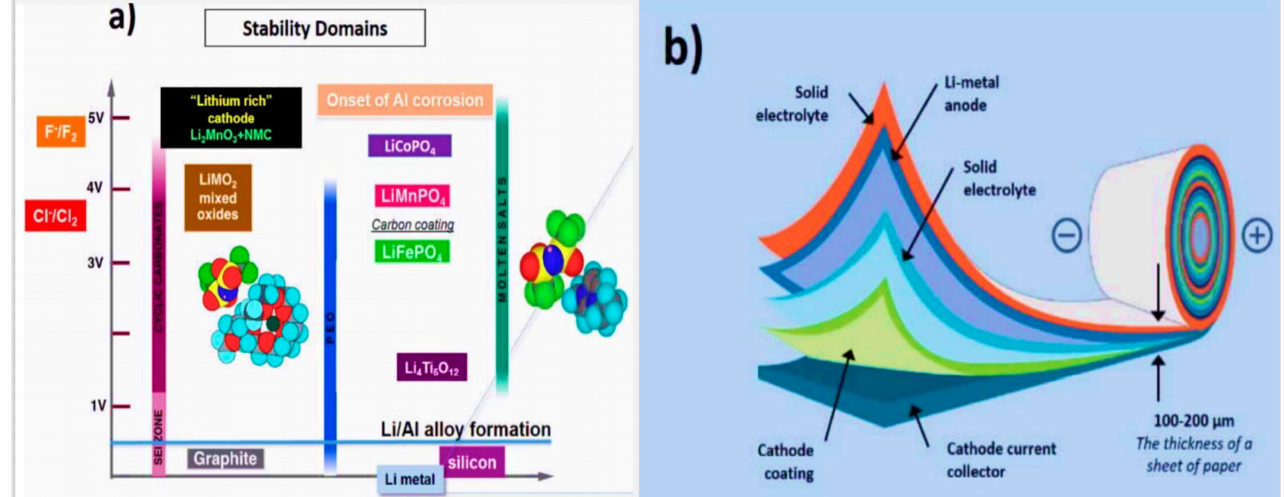
Figure 5. ( a ) Steadiness of diverse electrolytes and ( b ) solid-state lithium metal polymer battery architecture proposed by Michel Armand (adapted with permission from [95]. Materials,